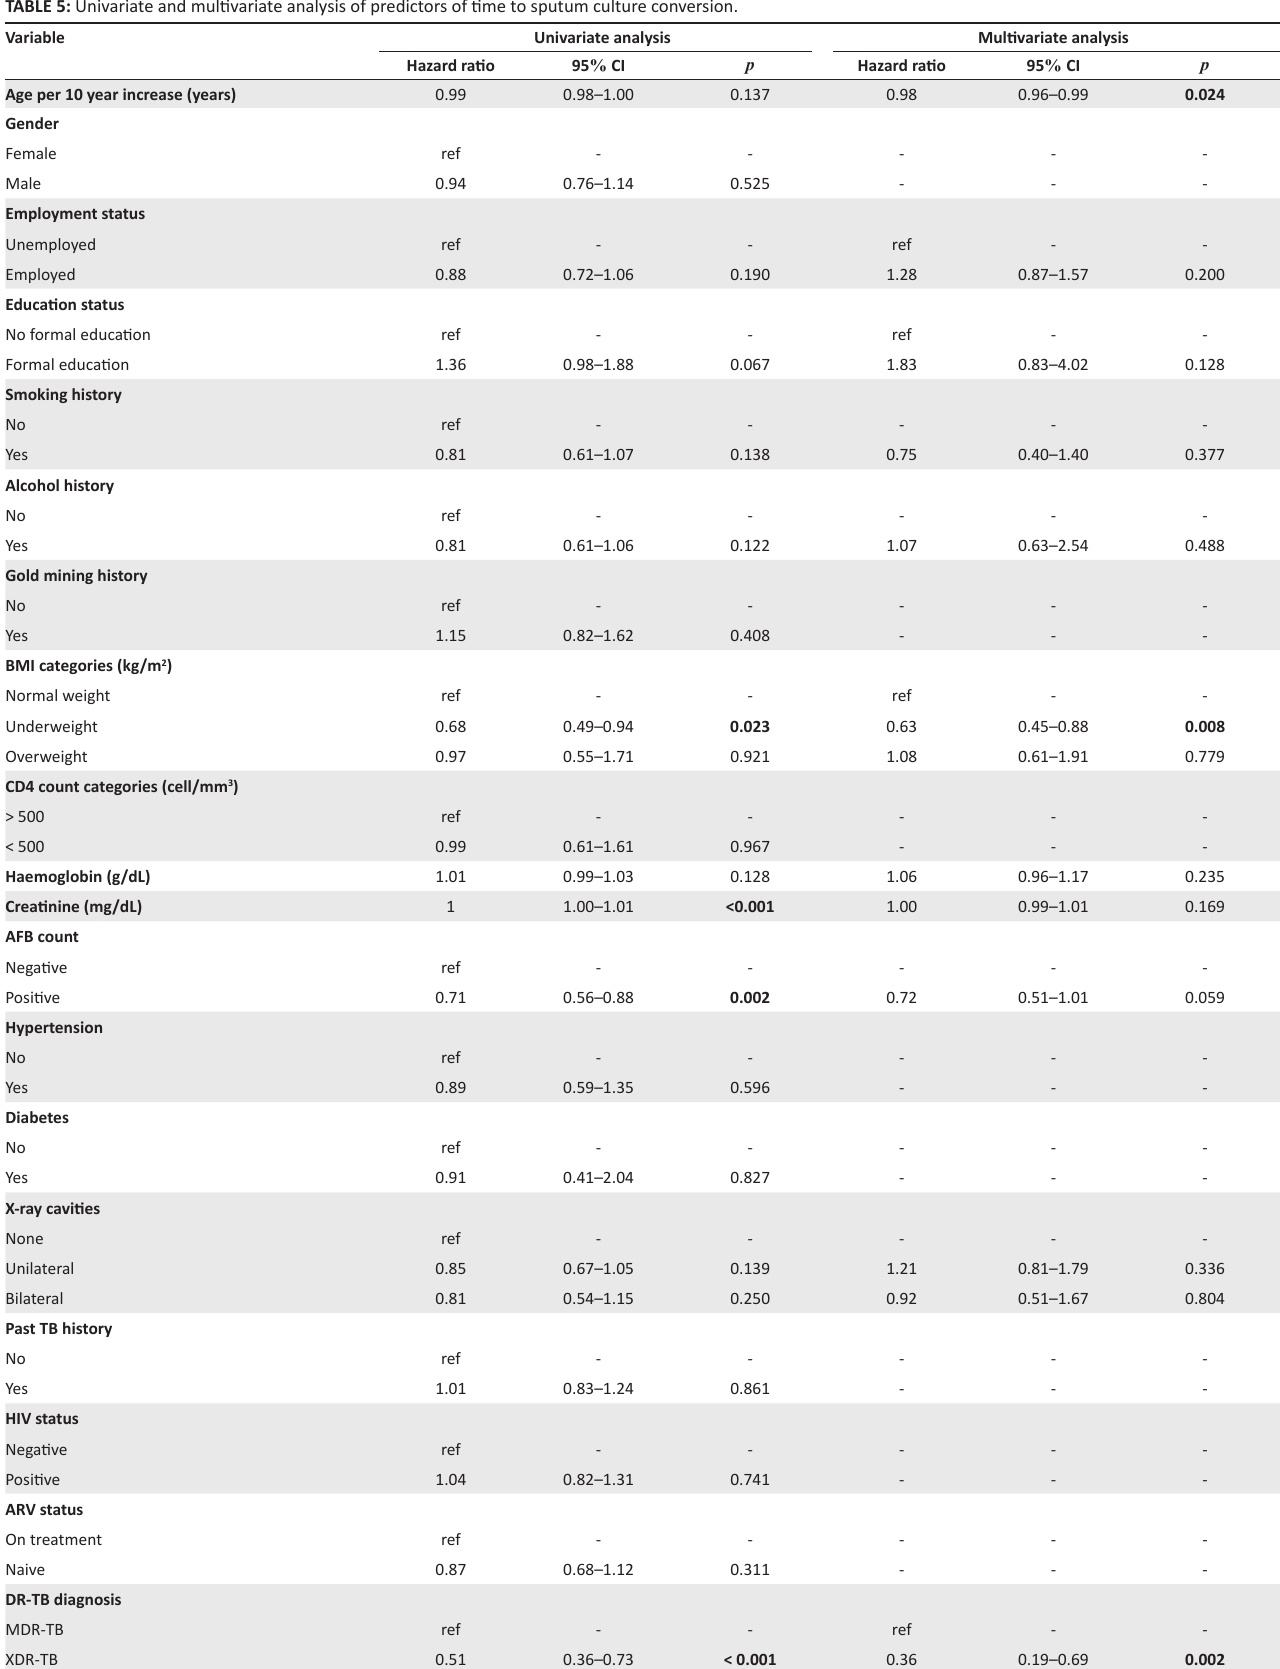
TABLE 5: Univariate and multivariate analysis of predictors of time to sputum culture conversion.